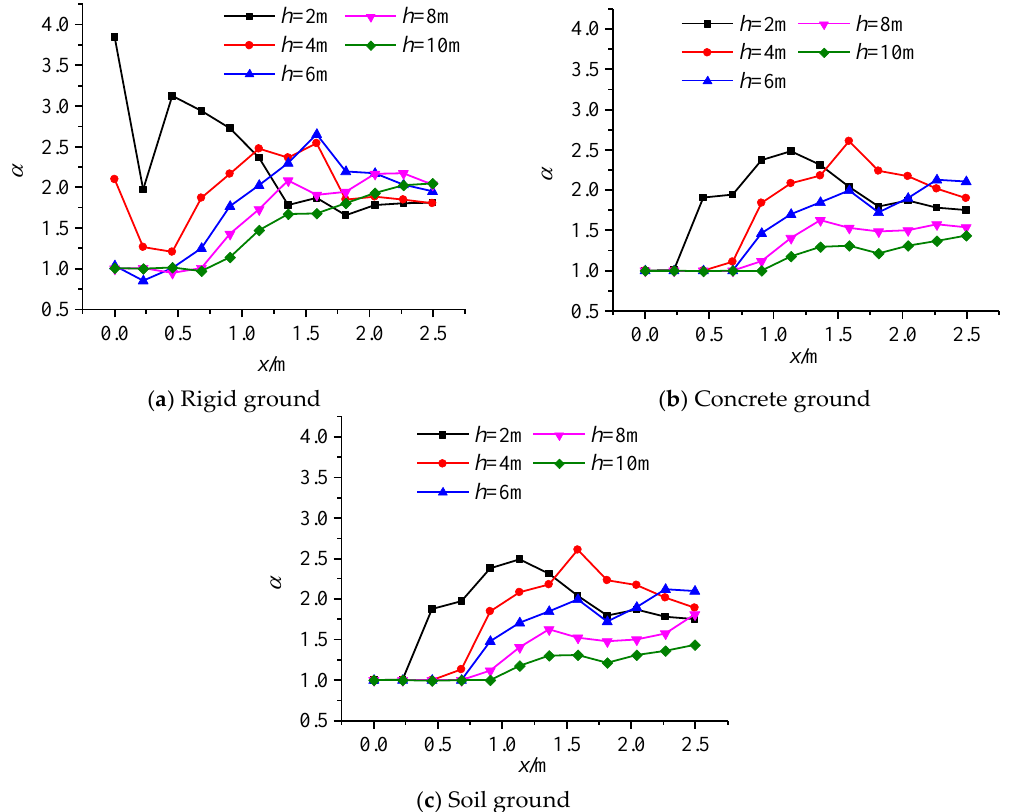
Figure 12. The peak overpressure factor of the explosion above different ground.